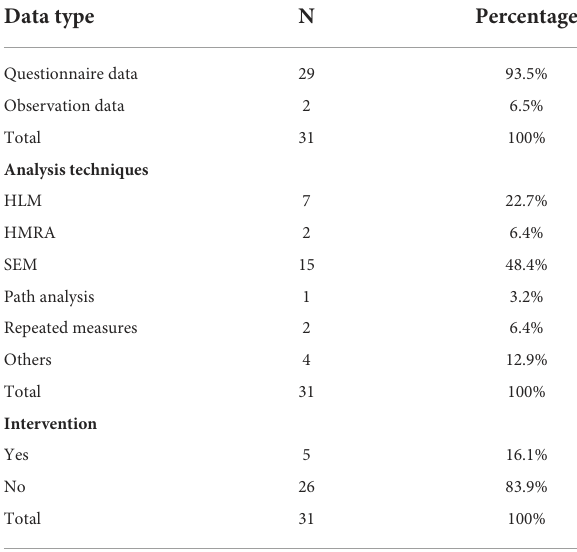
TABLE 7 Data type and analysis techniques.